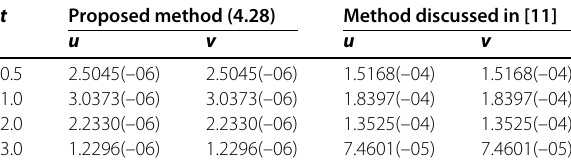
Table 14 Example 7: Maximum absolute error at ε = 1, α 1 = β 1 = –2, α 2 = β 2 = 1, h = 2 π /100, k = 0.01